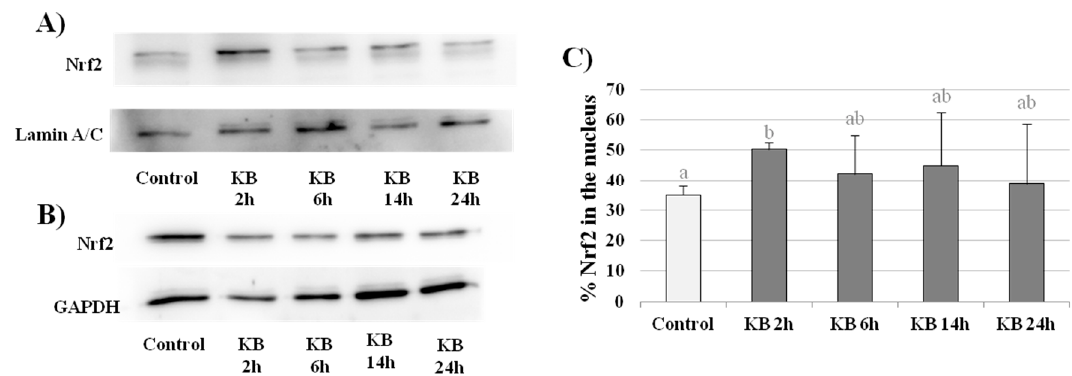
Figure 4. Western blot analysis. Nrf2 protein expression in control cells or cells treated with KB for 2, 6, 14 or 24 h in the nuclear ( A ) and cytoplasmic ( B ) fractions. Lamin A/C was used as a nuclear marker. GAPDH was used as a cytoplasmic marker. The western blot image is representative of four independent experiments ( A , B ). Densitometric analysis of Nrf2 protein expression was performed using lamin A/C as the loading control and Nrf2 nuclear translocation are expressed as the % of Nrf2 in the nuclear fraction compared to the total amount of Nrf2 in whole cells. Data are the mean ± SD of four independent experiments. Data not sharing a common letter are significantly different, p < 0.05 ( C ).